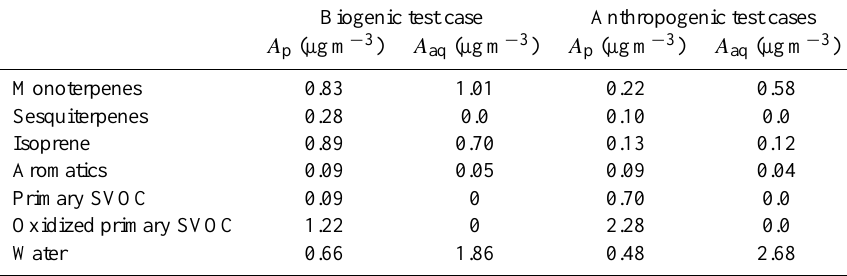
Table 6. Concentrations of organic aerosols formed for each precursor for both test cases at RH = 70% if ideality is assumed.